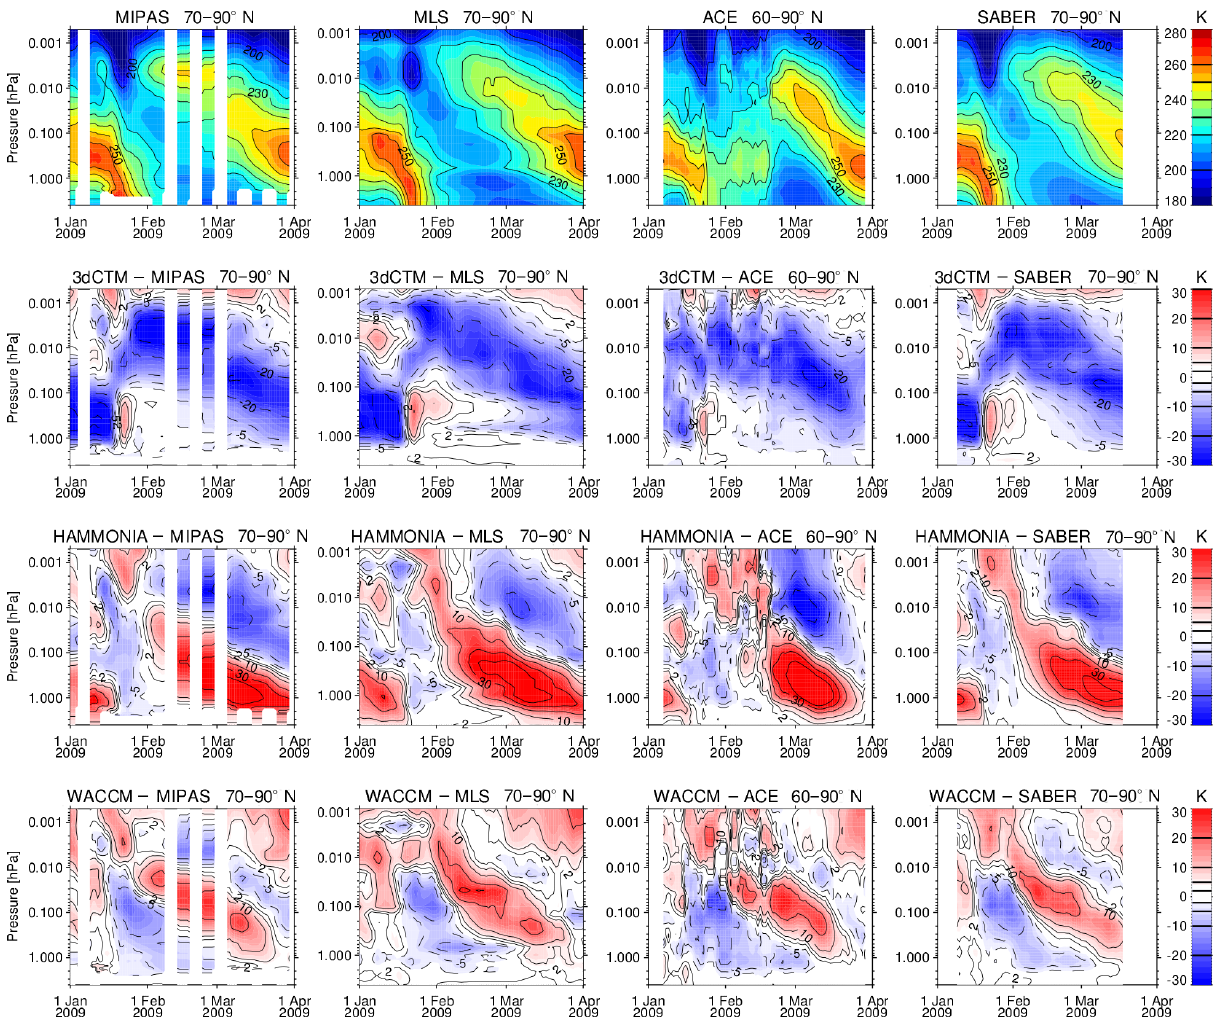
Figure 8. Top: temporal evolution of daily averaged polar cap temperatures at 4–0.0005hPa observed by MIPAS-UA, MLS/Aura, ACE-FTS, and SABER (from left to right). Bottom: corresponding differences between temperatures simulated with the “high-top” models (3dCTM, HAMMONIA, and WACCM) and the